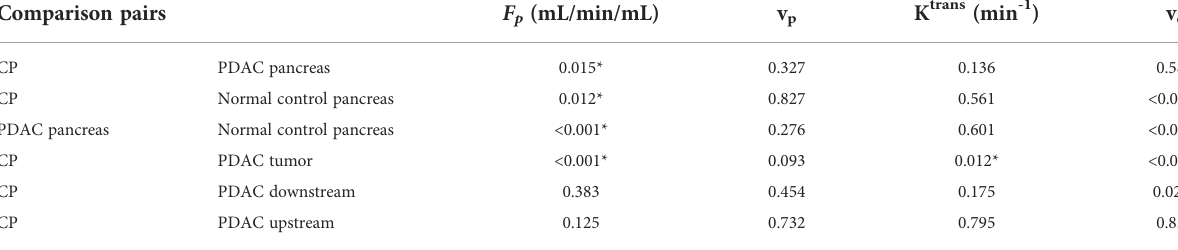
TABLE 3 The P value between some pairs of the tissues using one-way ANOVA analysis. Comparison